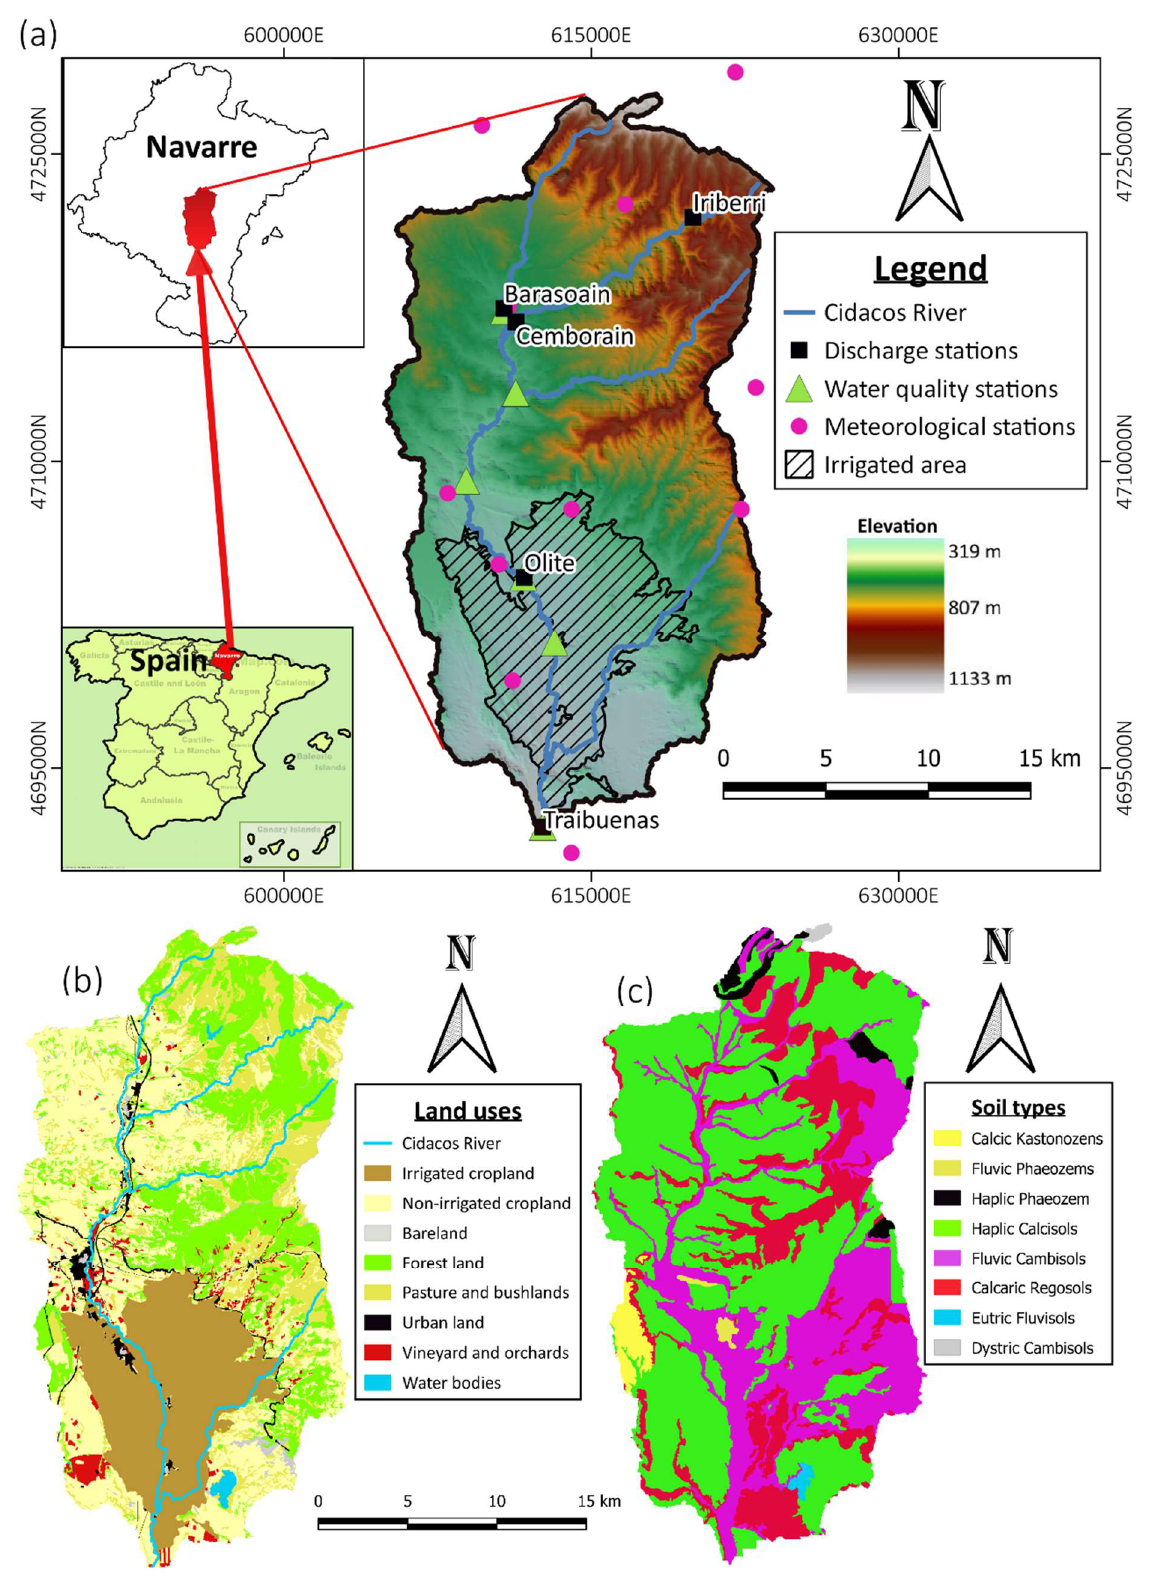
Figure 1. The Cidacos River watershed ( a ) location, elevation, and stations; ( b ) land use map, and ( c ) soil map.